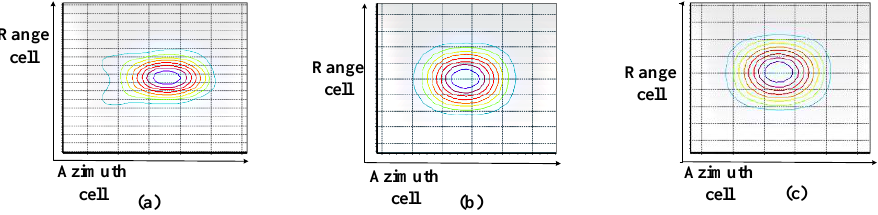
Table 2. Results of the imaging algorithm with three weighting method.